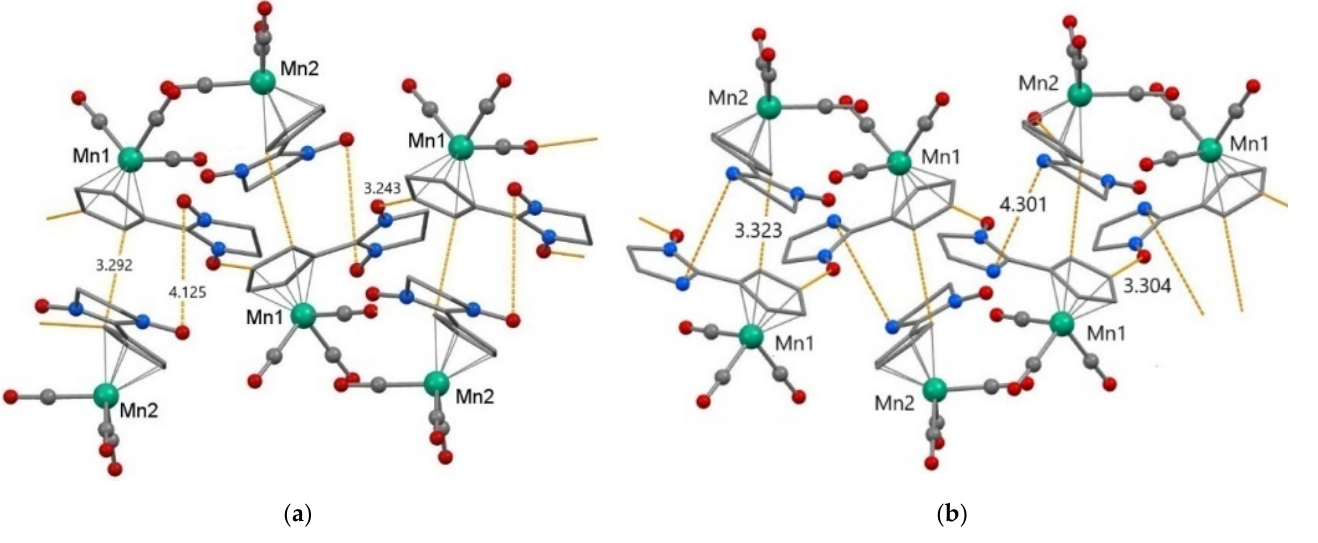
Figure 1. Fragments of crystal structure and the shortest intermolecular distances (Å) in NNMn ( a ) and INMn ( b ). Color scheme: Mn—green, O—red, C—grey, and N—blue. The H atoms, the geminal CH 3 groups and disordered O atoms of NO groups in positions with a weight of 0.2 for INMn are omitted for clarity.